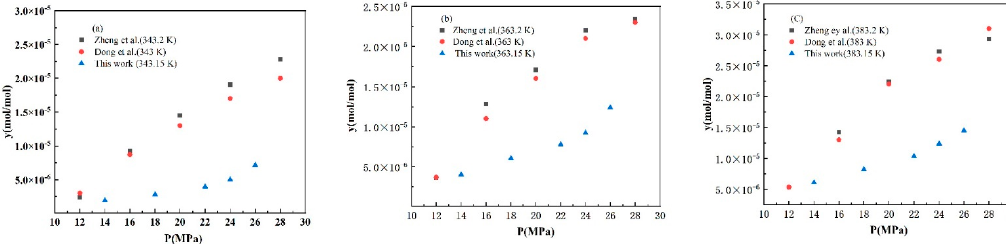
Figure 6. Comparison of solubility of DR 73 at ( a ) 343.15 K, ( b ) 363.15 K, ( c ) 383.15 K.